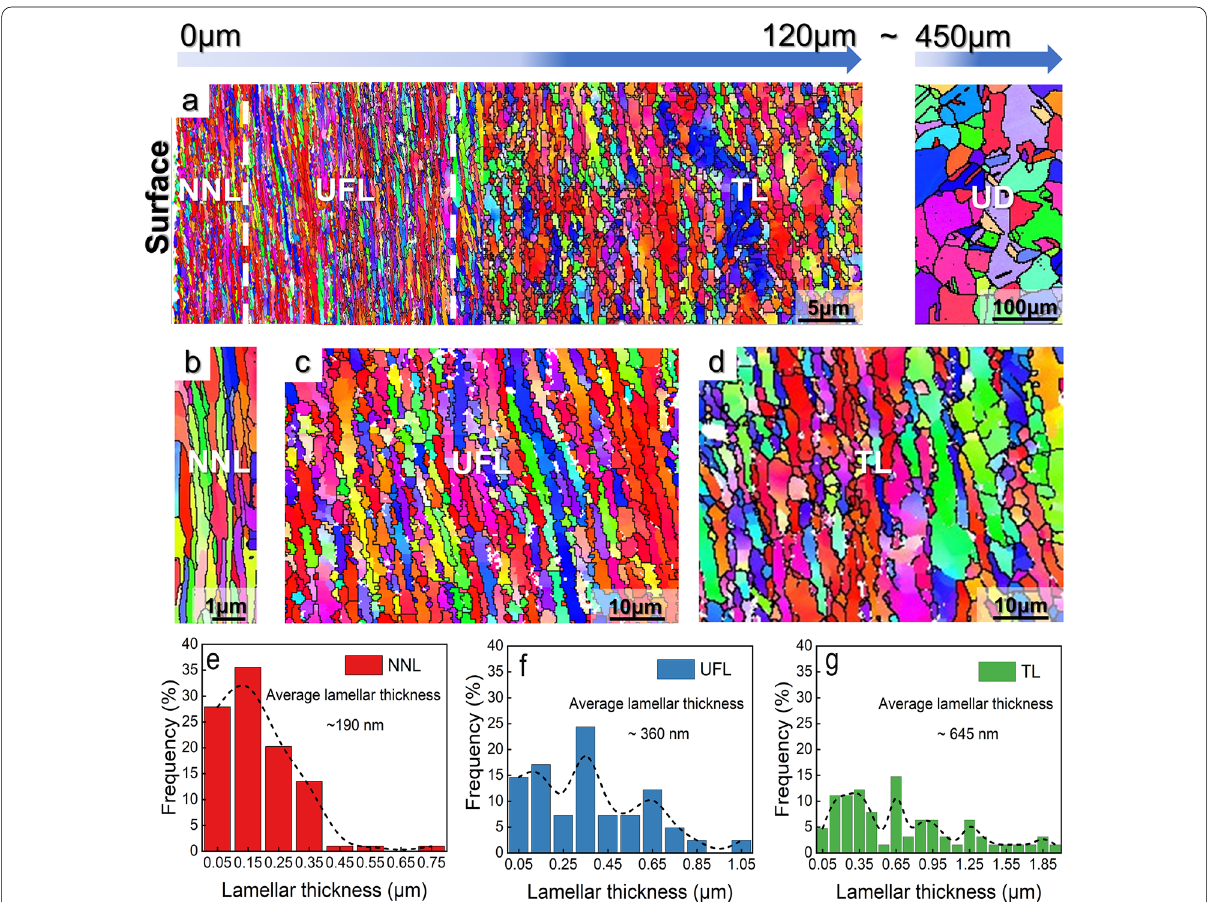
Figure 3 ( a ) The gradient lamellar microstructure of the UADRed Ni. EBSD images and lamellar thickness distribution of ( b ) and ( e ) NNL, ( c ) and ( f ) UFL, ( d ) and ( g ) TL